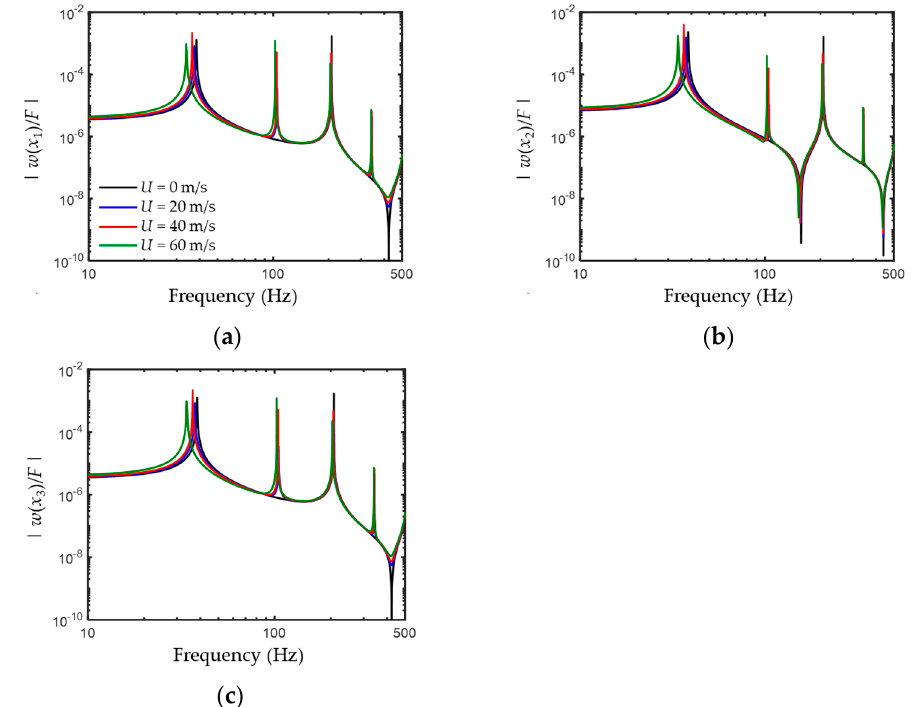
Figure 4. Analytical transfer functions for fluid-conveying pipe at ( a ) x = x 1 , ( b ) x 2 , and ( c ) x 3 with varying flow velocities.